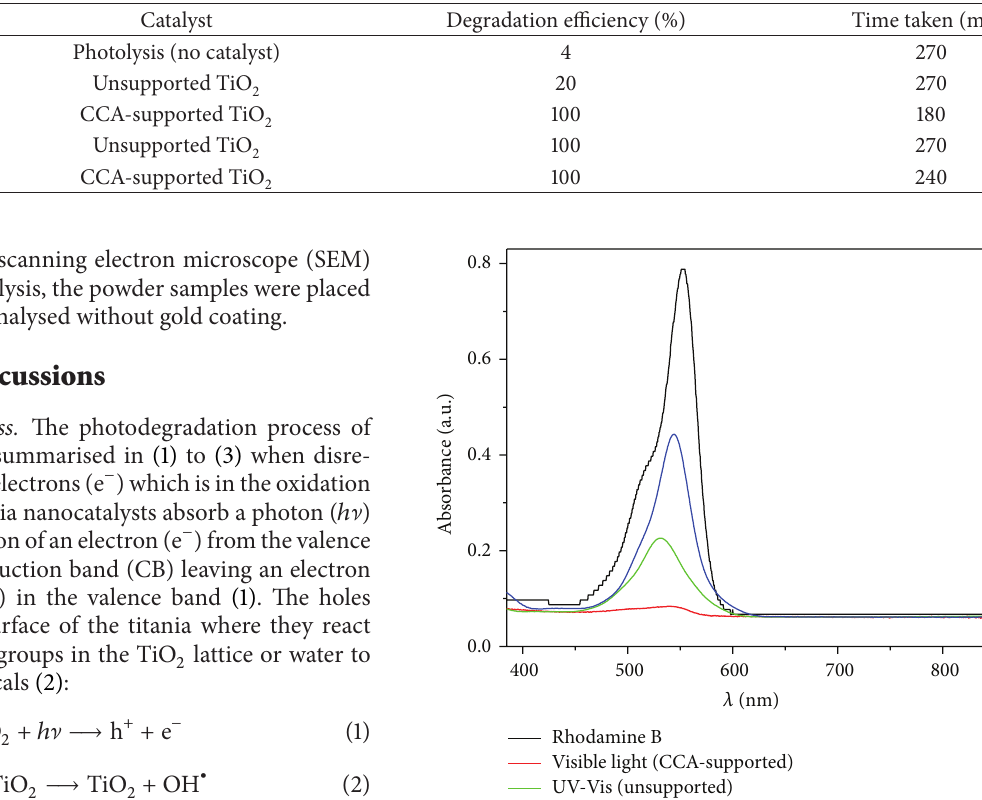
Table 1: Comparison of photodegradation efficiencies of Rhodamine B by free and CCA/TiO